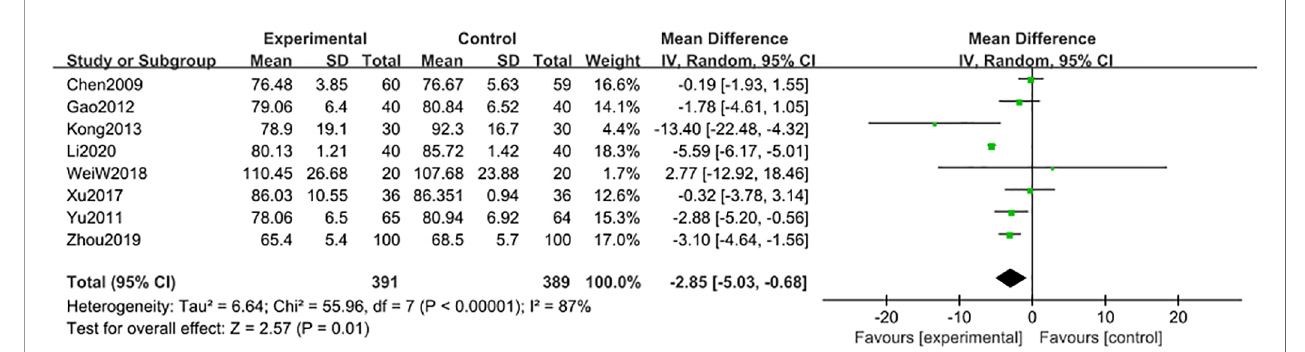
FIGURE 9 | Blood creatinine level after 6 months: comparison of treatment combined with TG against basic